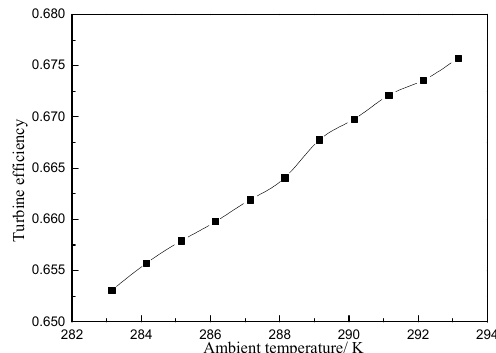
Figure 17. Turbine efficiency at different ambient temperature.